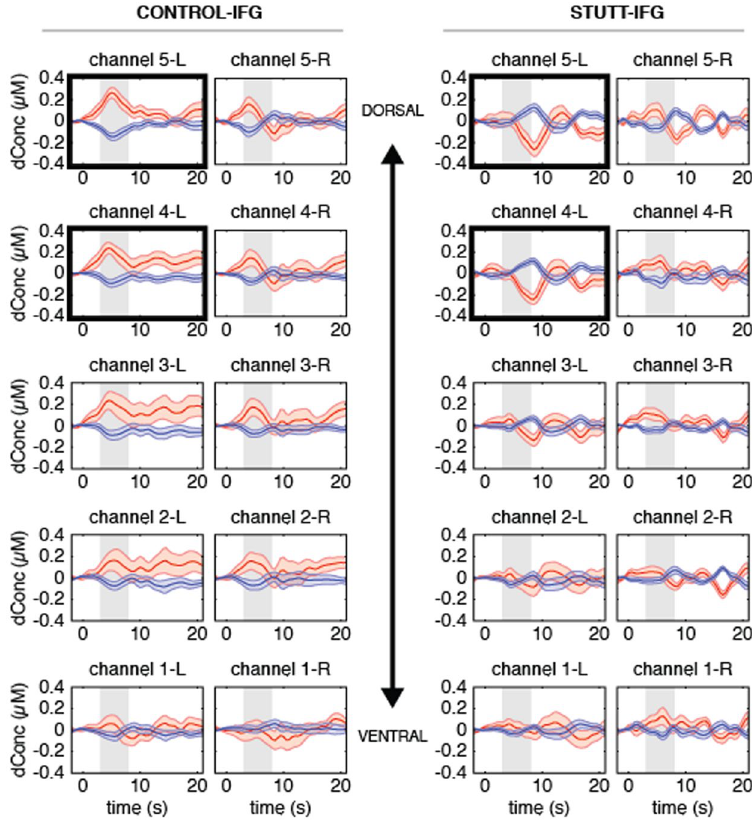
Figure 1. Grand averaged Oxy-Hb (red) and Deoxy-Hb (blue) hemodynamic responses with standard error curves for IFG channels. Channels for the controls (n = 16) are shown on the left hand side of this figure and channels for the children who stutter (n = 16) are plotted on the right. Within each participant group, left hemisphere channels are plotted side-by-side with homologous right channels for comparison. Channels showing a significant group difference are bold-framed. Time = 0 indicates trial onset. Gray shading indicates the 3–8 s. window of analysis.